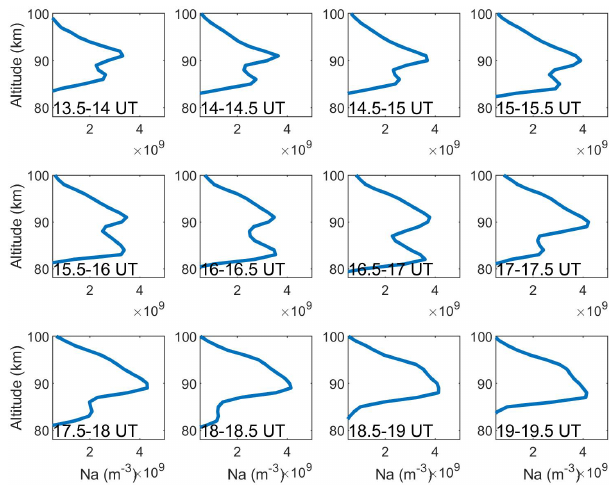
Table 1. The altitudes and densities of the main and the